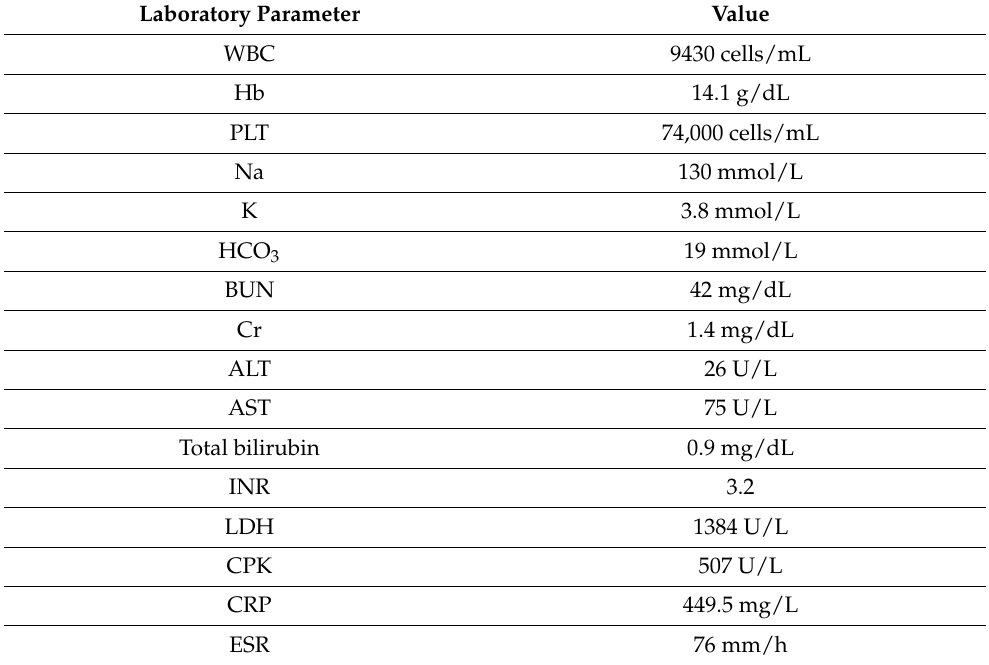
Table 1. Laboratory parameters on admission. Laboratory Parameter Value